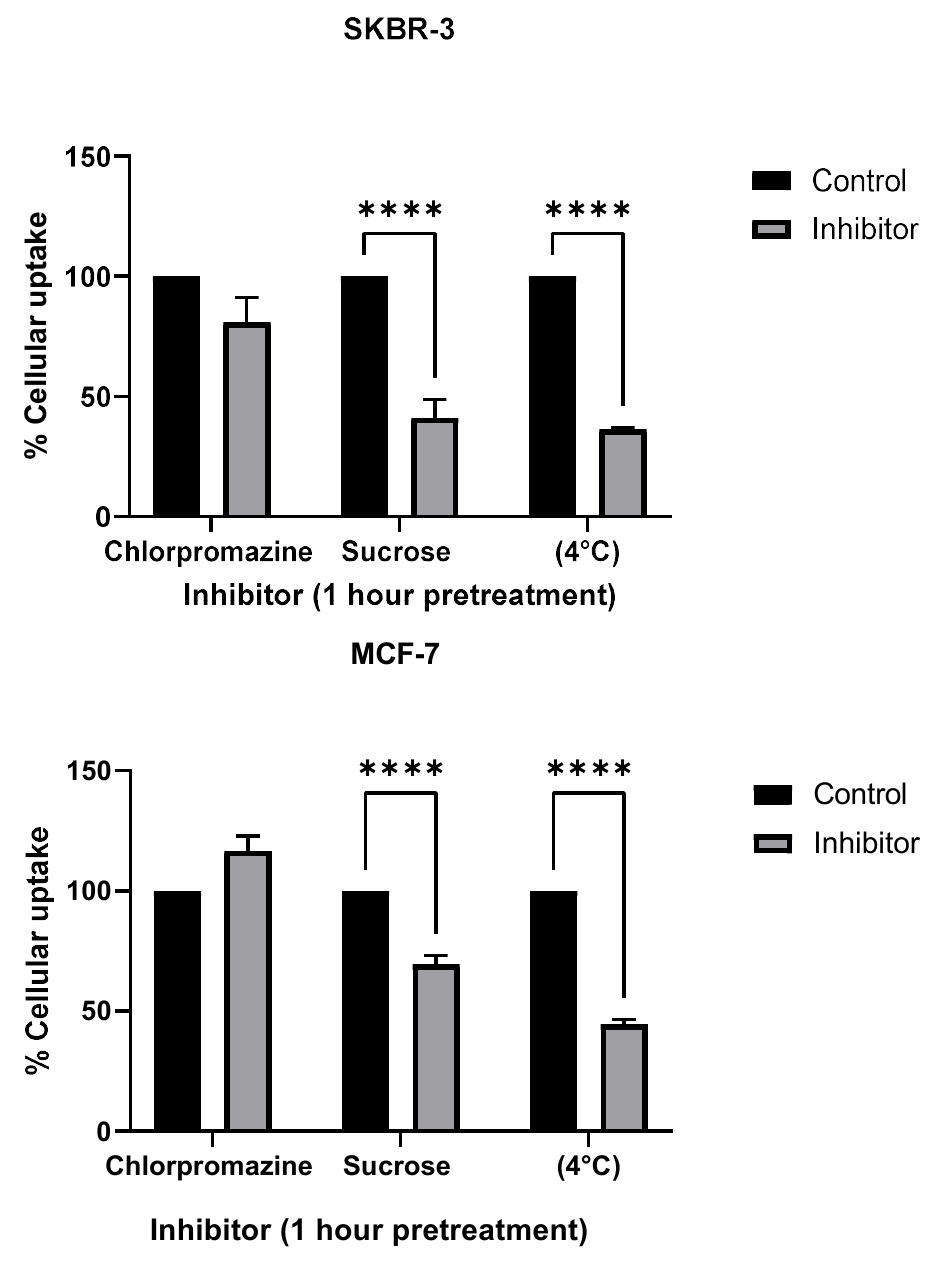
Figure 6. Cellular uptake analysis of AuNRs in SKBR-3 cells using TEM. To confirm internalization and the mechanism of endocytosis, clathrin pits were analyzed (pit circled in red). Due to the ag- gregation of AuNRs, the clumps were too large for receptor-mediated endocytosis and no AuNRs were observed to be localized in coated pits or vesicles. The electron photomicrograph shown is representative of at least three independent experiments with similar conditions. The same trend was observed in MCF-7 cells.